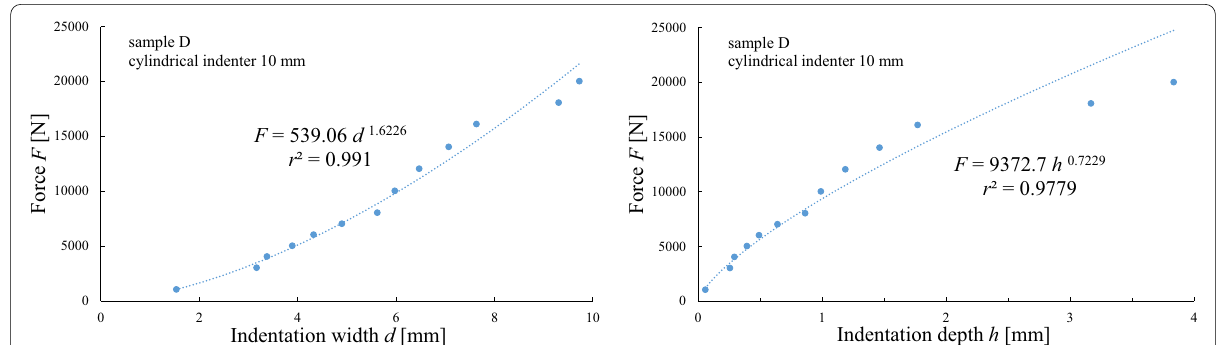
Fig. 6 Comparison of Meyer power law for the force dependence on the width of indentation (left chart) with Monnin measure determining the force dependence on the depth of indentation (right chart). The data refer to indentations with a 10‑mm‑diameter cylinder on beech wood (sample D)